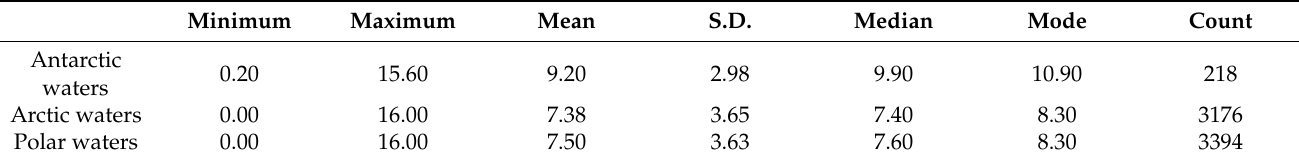
Figure 3. The speed distribution of the ship movement in polar waters. Table 1. Statistics of ship speeds in polar waters. Table 1. Statistics of ship speeds in polar waters